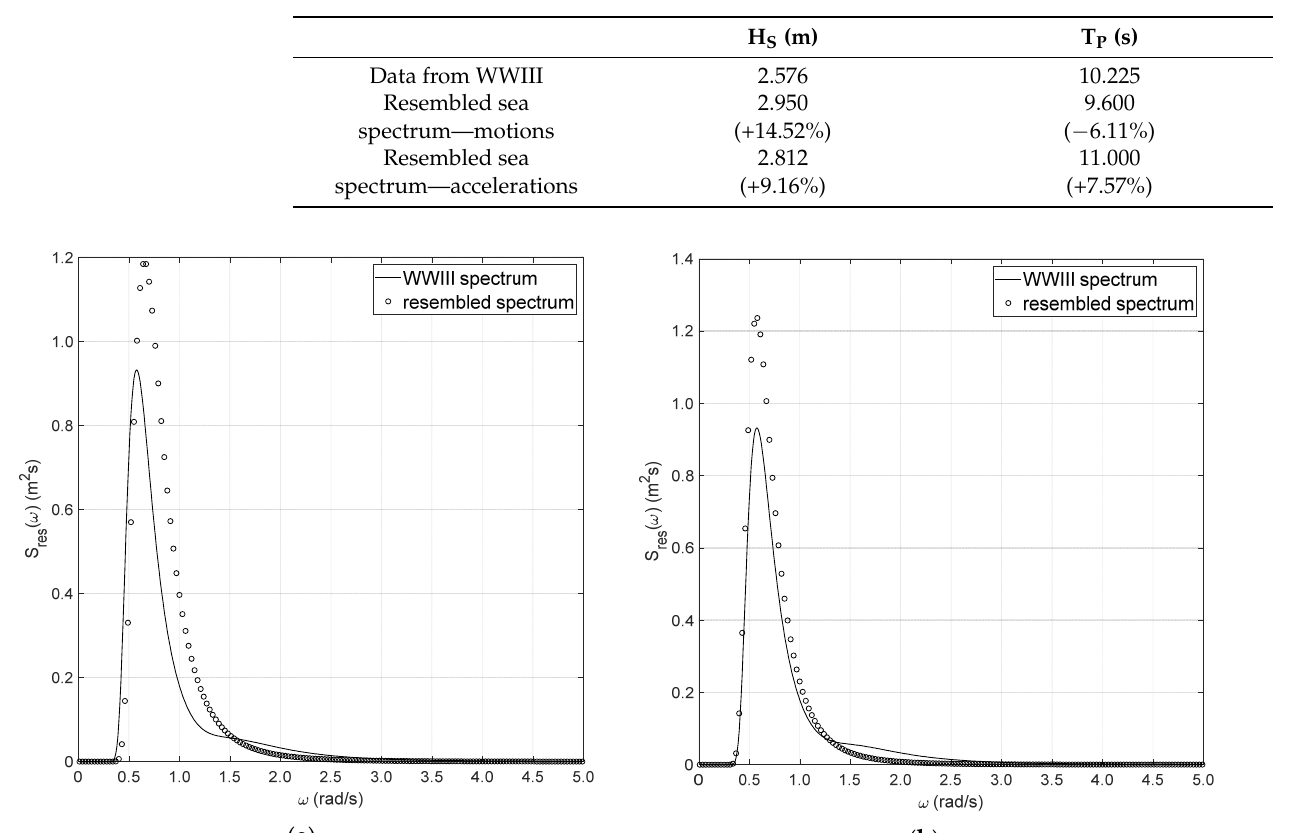
Table 4. Parameters of rebuilt spectrum for a combined sea spectrum—8 January 2020.